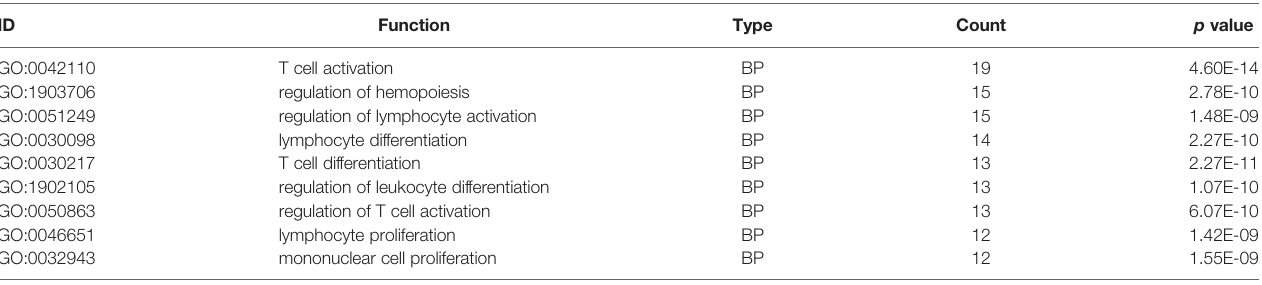
TABLE 3 | Immune cell function GO clustering of signi fi cantly differentially expressed gene.